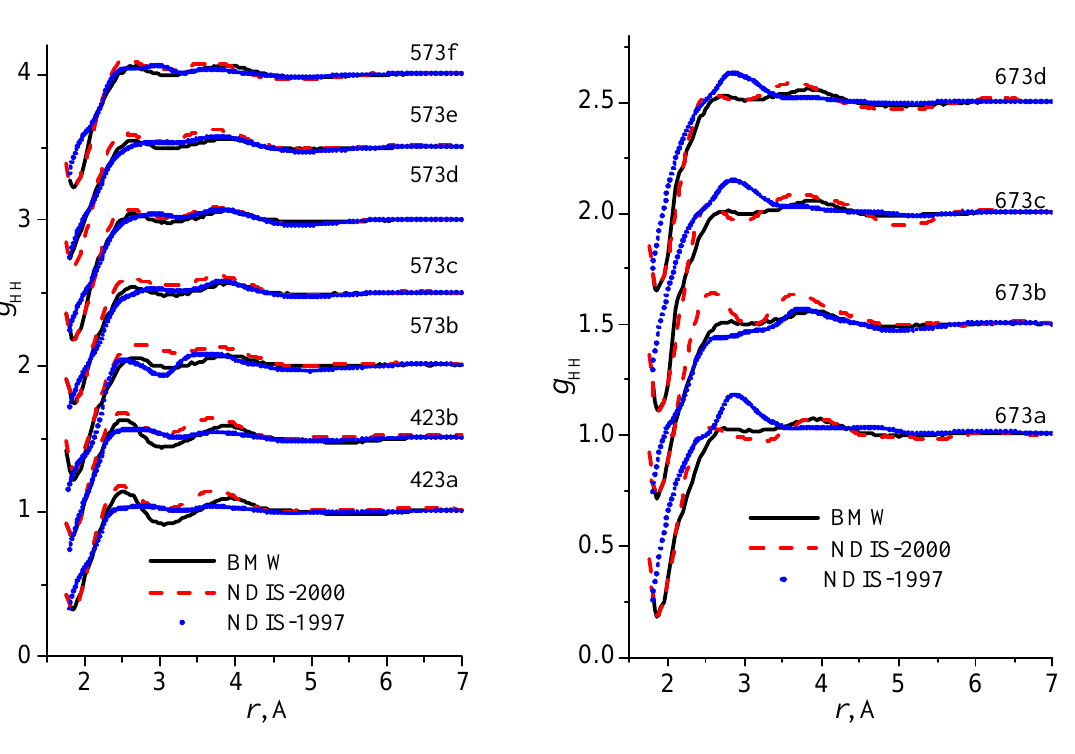
Figure 11. Radial distribution functions g